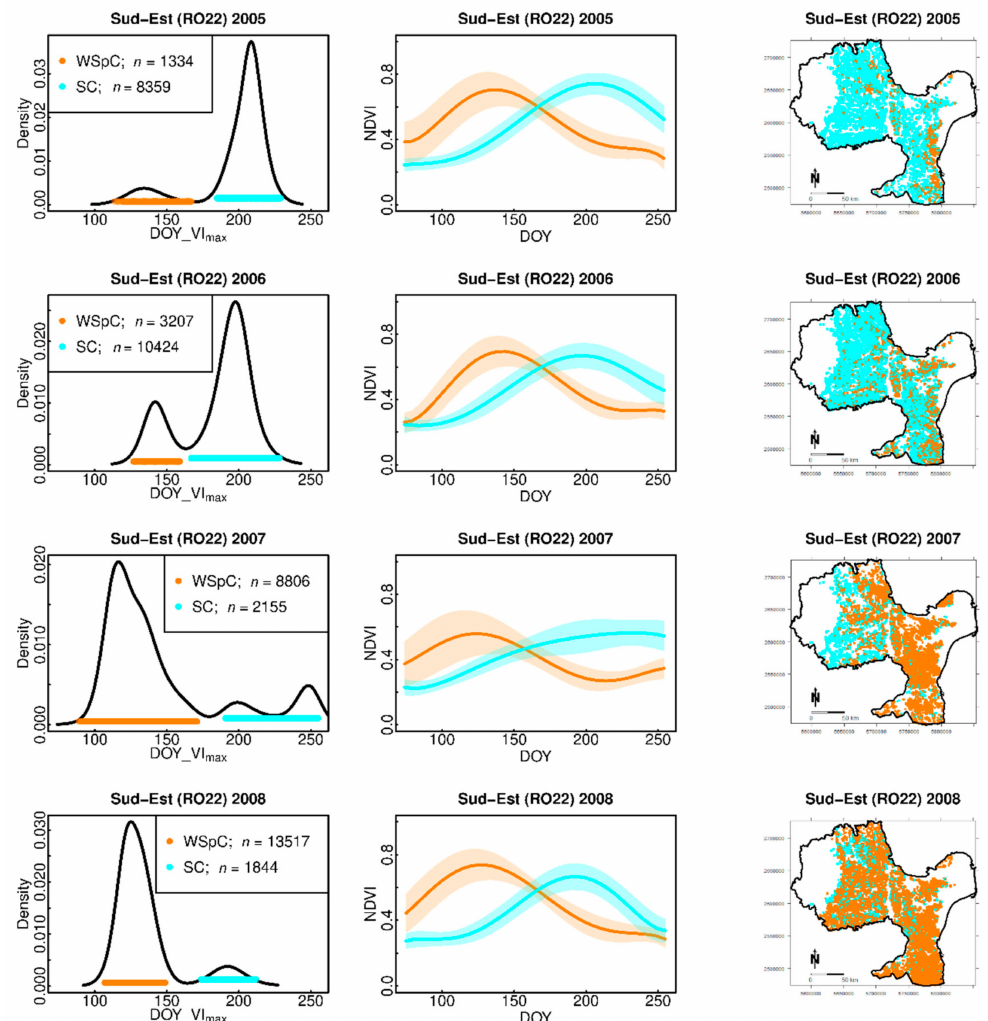
Figure 6. Probability density function of DOY_VImax (first column), NDVI timeseries (2nd column), and geographic distribution (3rd column) of the two crop group’s pure pixels for the region Sud-Est (Romania) in 2005–2008 (by row). Winter / spring crops (WSpCs, orange), summer crops (SCs, cyan). The timeseries depicts mean run ± 1